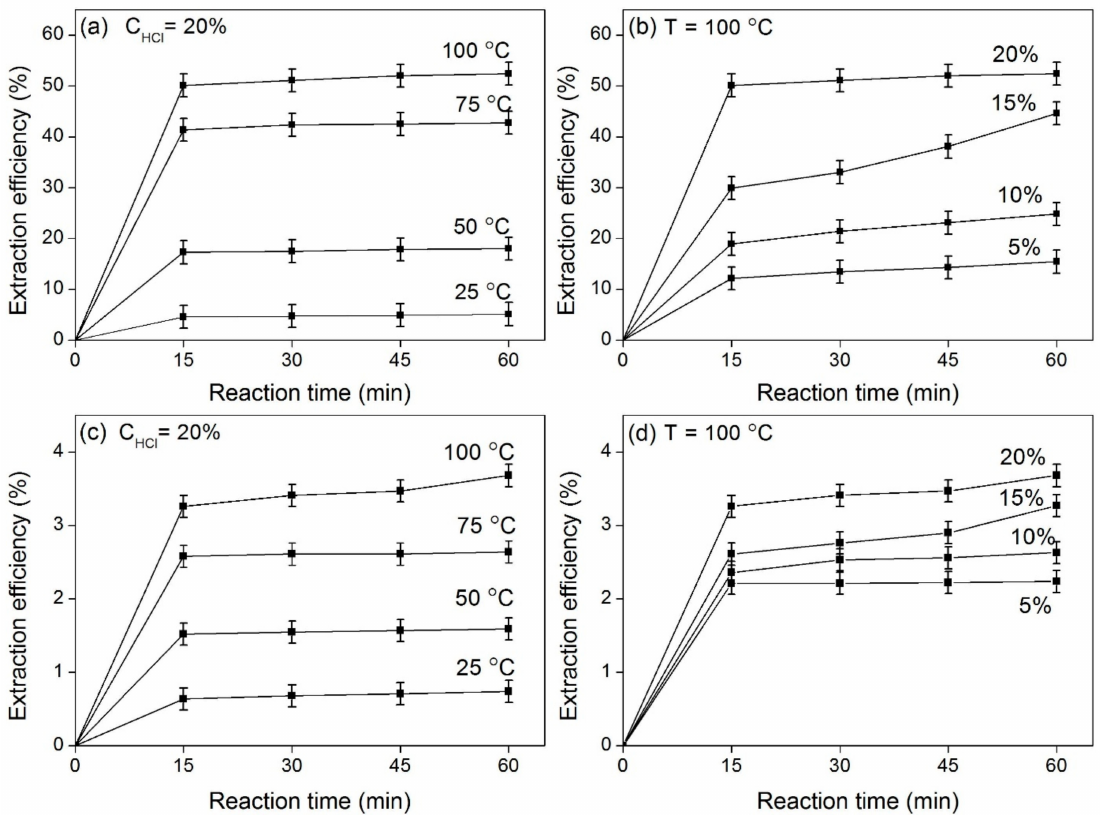
Figure 3. Effect of temperature, HCl concentration and time on CFA leaching at S:L = 1:10, ω stir bar = 300 rpm: ( a , b ) iron extraction efficiency, ( c , d ) aluminum extraction